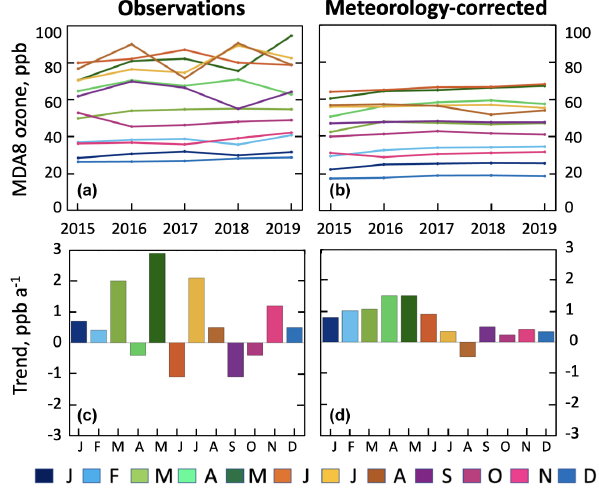
Figure 6. Same as Fig. 5 but for 24h average NO 2 concentrations. Trends are shown in percent per annum relative to the 2015–2019